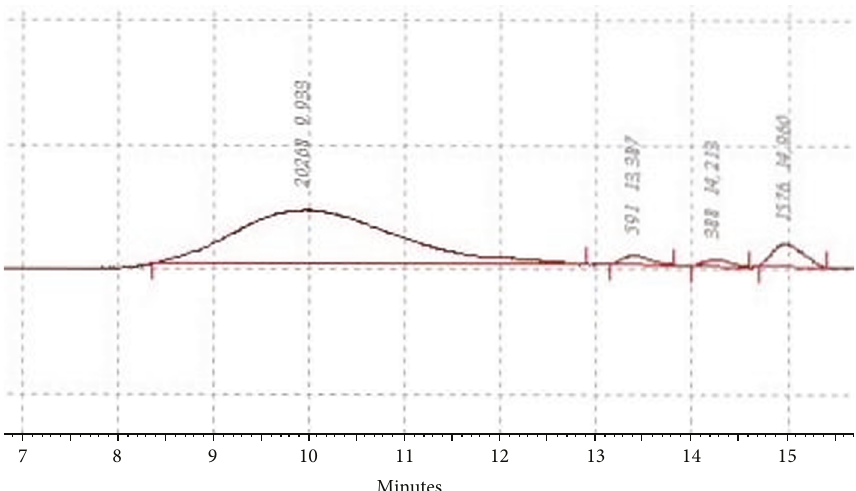
Figure 1: HPSEC elution pattern of ammonium oxalate-extracted common fumitory pectin. Pullulan standards (6200 – 805,000 Mw range) were used to estimate the molecular